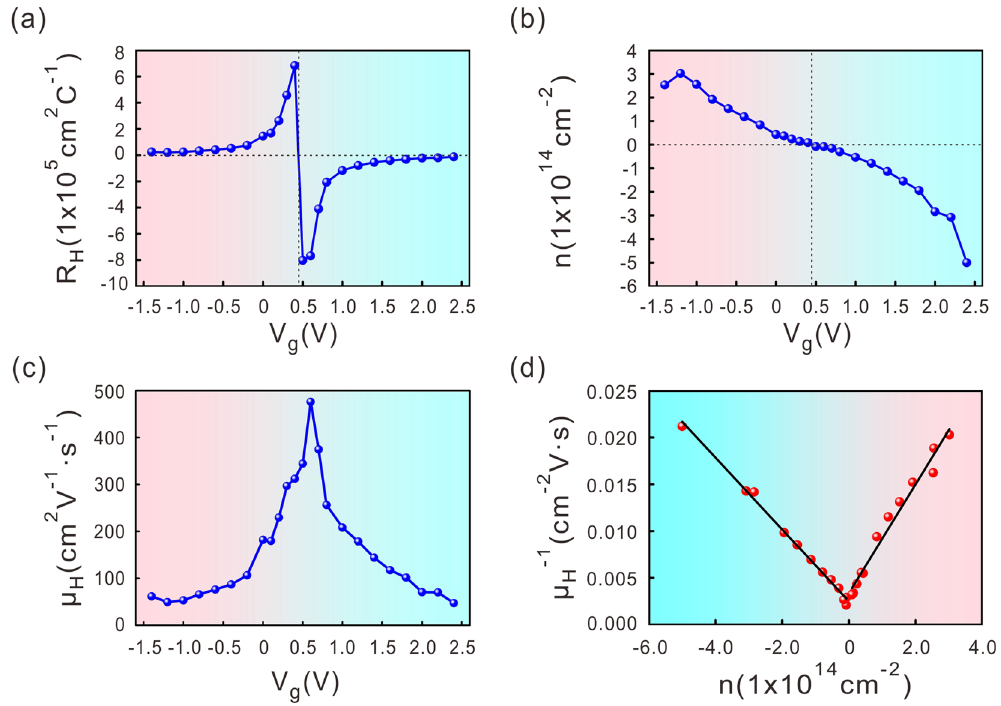
Figure 2. The Hall coefficient ( a ), carrier density ( b ) and Hall mobility ( c ) of a single-layer graphene sheet as a function of the back-gate voltage. The measurements were performed at room temperature. ( d ) The inverse Hall mobility as a function of the carrier density. Solid lines are the linear fitting